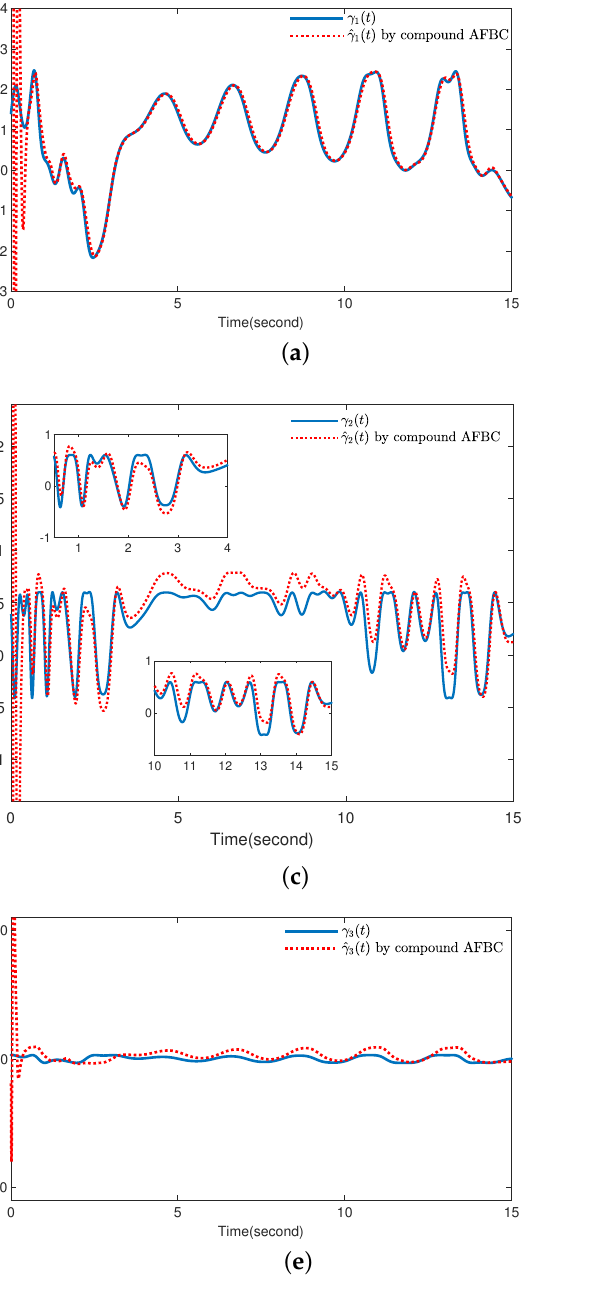
Figure 5. Comparison results: ( a ) the approximation effect of γ 1 by utilizing the compound AFBC; ( b ) the approximation effect of γ 1 by utilizing the AFBC; ( c ) the approximation effect of γ 2 by utilizing the compound AFBC; ( d ) the approximation effect of γ 2 by utilizing the AFBC; ( e ) the approximation effect of γ 3 by utilizing the compound AFBC; ( f ) the approximation effect of γ 3 by utilizing the